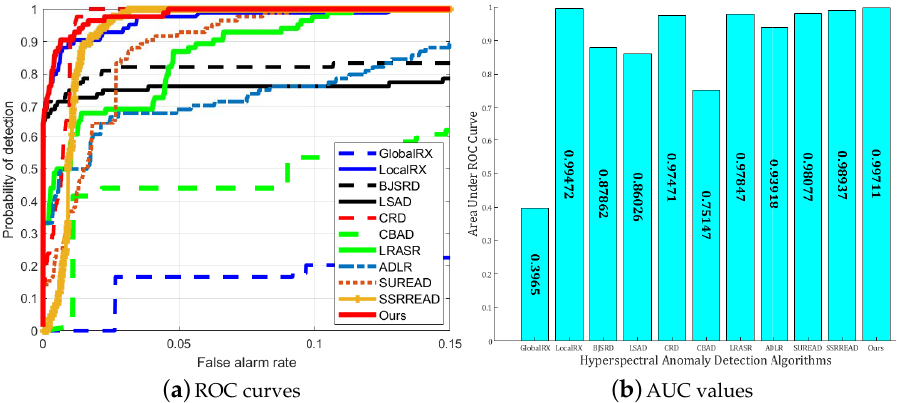
Figure 9. ROC curves and AUC values for the simulated